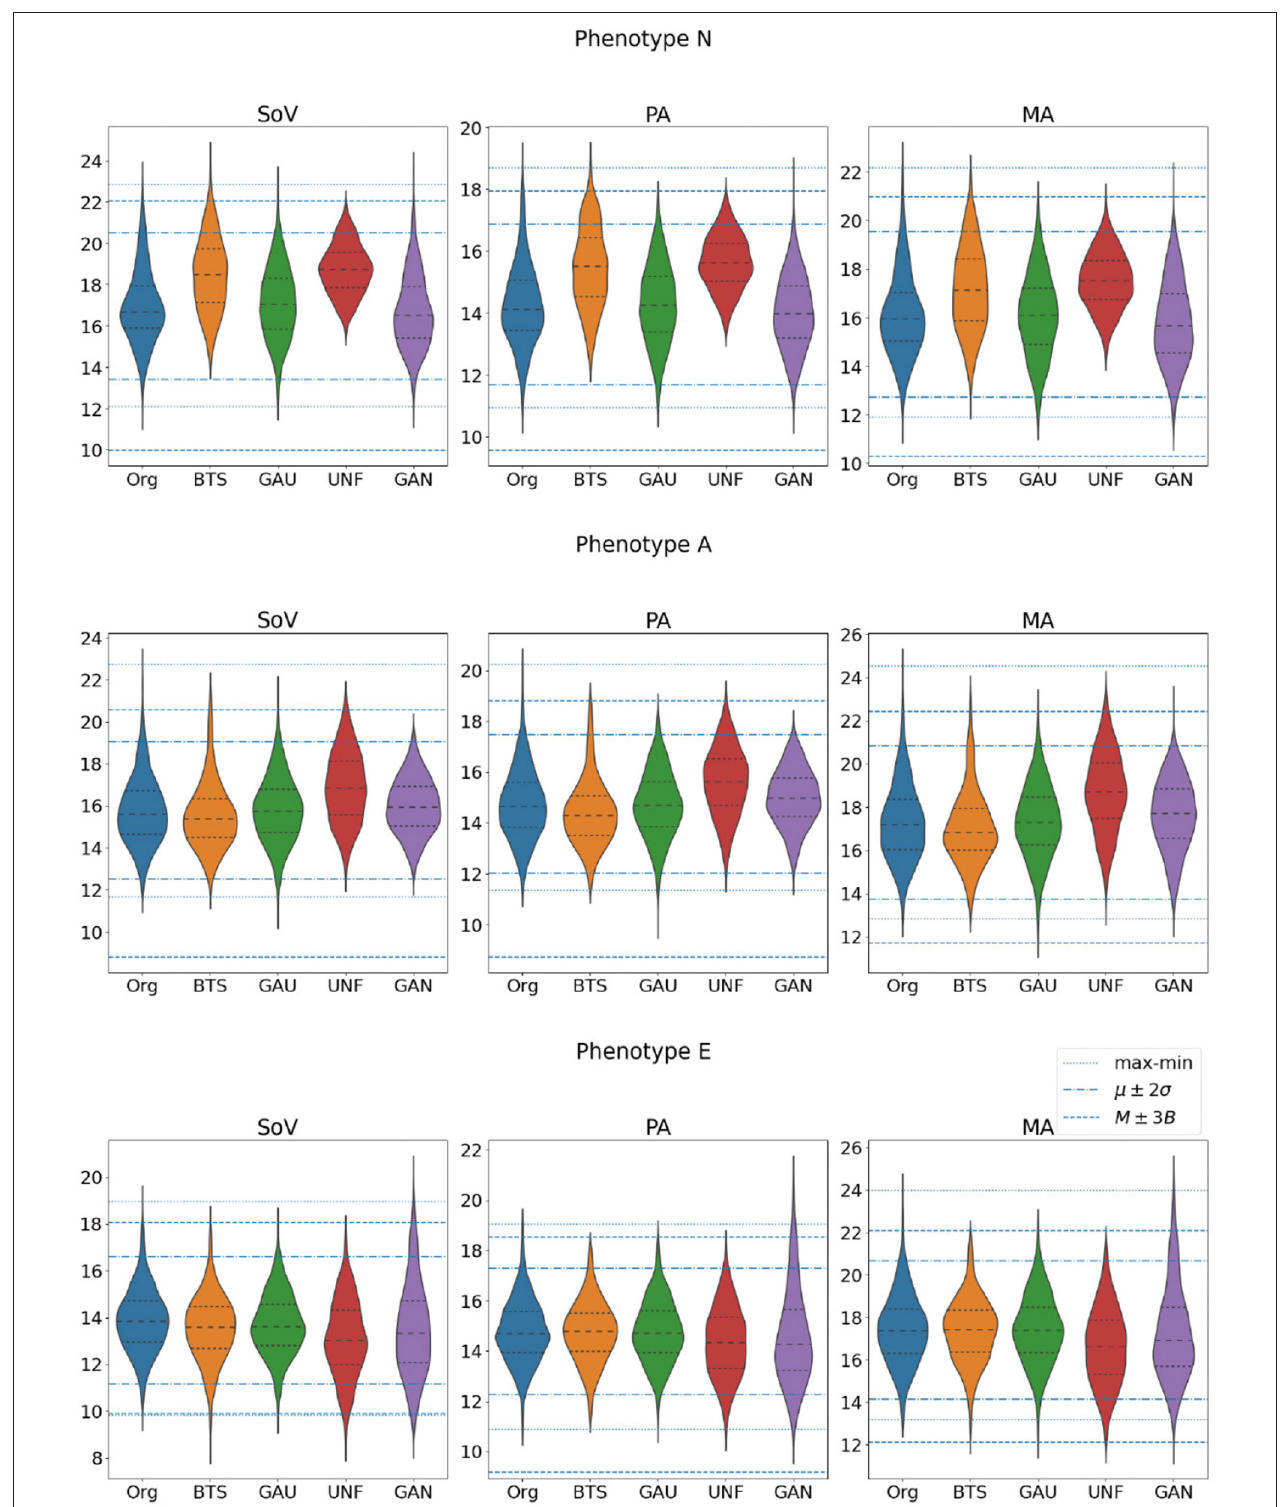
FIGURE 7 | Distributions of the three biomarkers that define the target phenotypes (SoV, PA, and MA) in the set of aortas that actually belong to each one of the three classes. All the values are in millimeters.